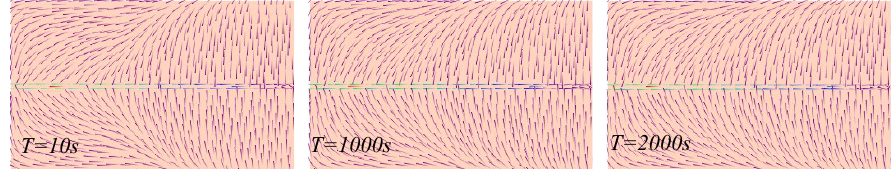
Figure 19. Flow fields at different times in scenario A.